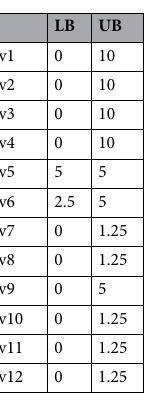
Table 1. The result of FVA on the reactions in the metabolic model of Fig. 1A. The minimum and the maximum range of each reaction flux are shown for the metabolic model in Fig.